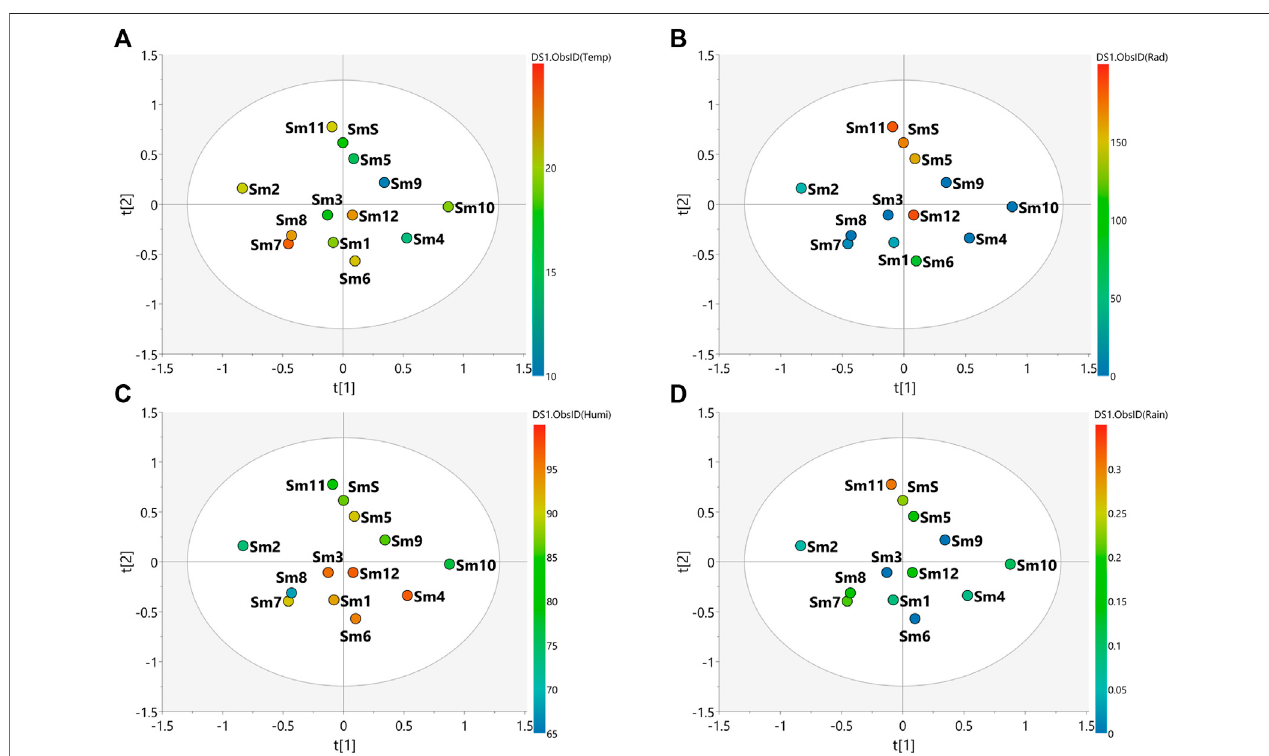
FIGURE 4 | PLS-DA score scatter plots of the MS-NMR fused data of S. marginata seasonal harvests and the correlation with the environmental factors. Samples are categorized according to the values of observations for environmental factors. (A) Temp (cid:2) temperature ( ° C); (B) Rad (cid:2) Solar radiation (kJ/m 2 ); (C) Humi: relative humidity (%) and (D) Rain (cid:2) rainfall (mm). Sample seasons: Summer (Sm1, Sm6 and Sm12); Autumn (Sm2, Sm3, Sm7 and Sm8); Winter (Sm4, Sm9 and Sm10) and Spring (Sm5, Sm11 and